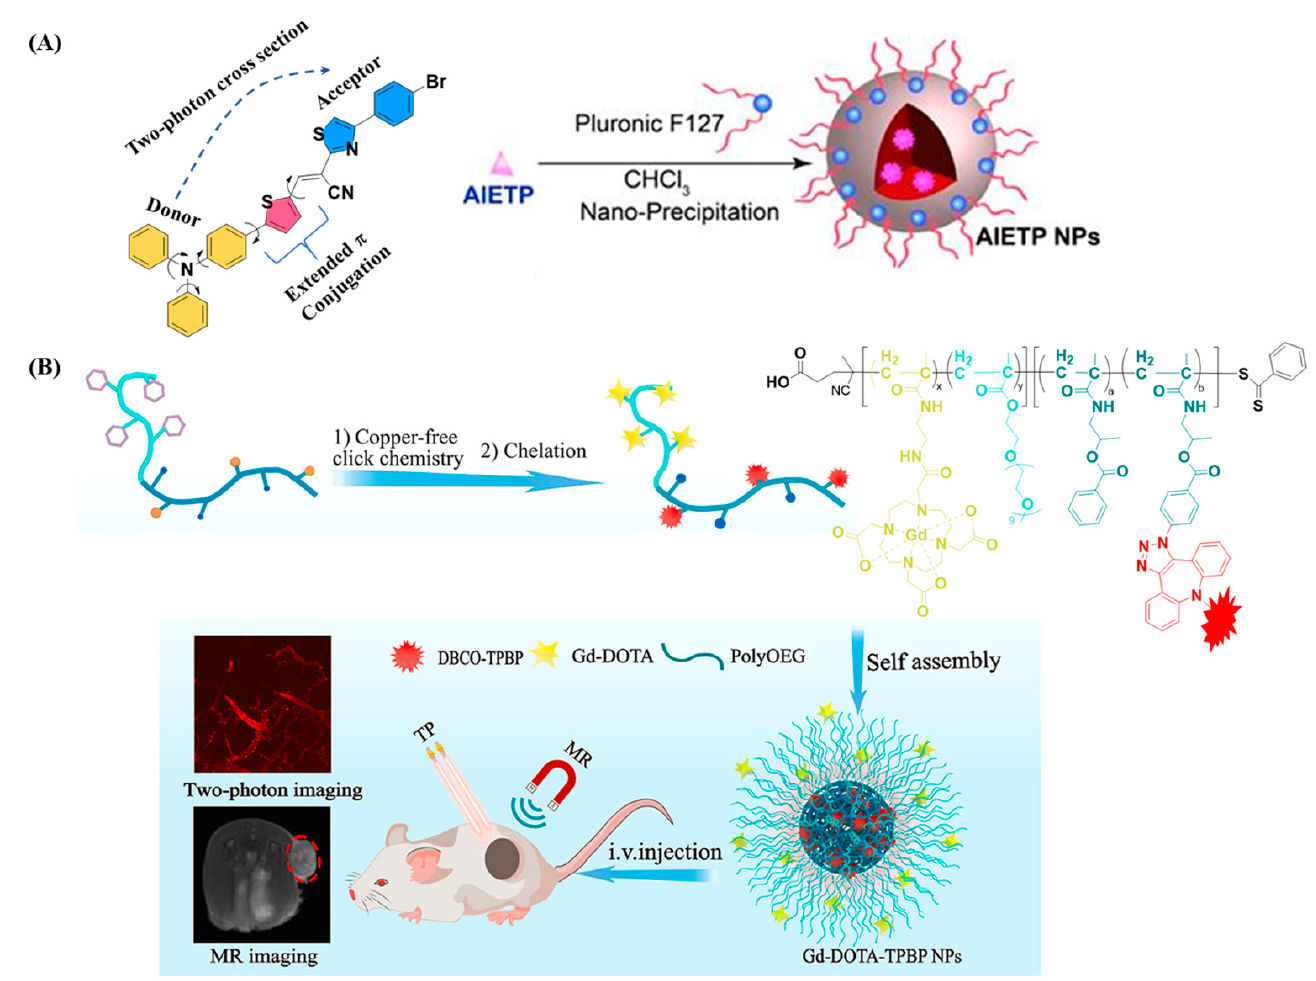
Figure 3. ( A ) Chemical structure of AIETP probe, and illustration for the preparation of AIETP- loaded Pluronic F127 nanoparticles. Adapted with permission from ref. [30] Copyright 2019 The Authors, Published by Theranostics. ( B ) Schematic representation of synthesis of amphiphilic block copolymer containing AIE probe TPBP and Gd-DOTA contrast agent for two-photon fluorescence and magnetic resonance imaging. Adopted with permission from ref. [44] Copyright 2022 The Au- thors. Published by KeAi Communications Co., Ltd.